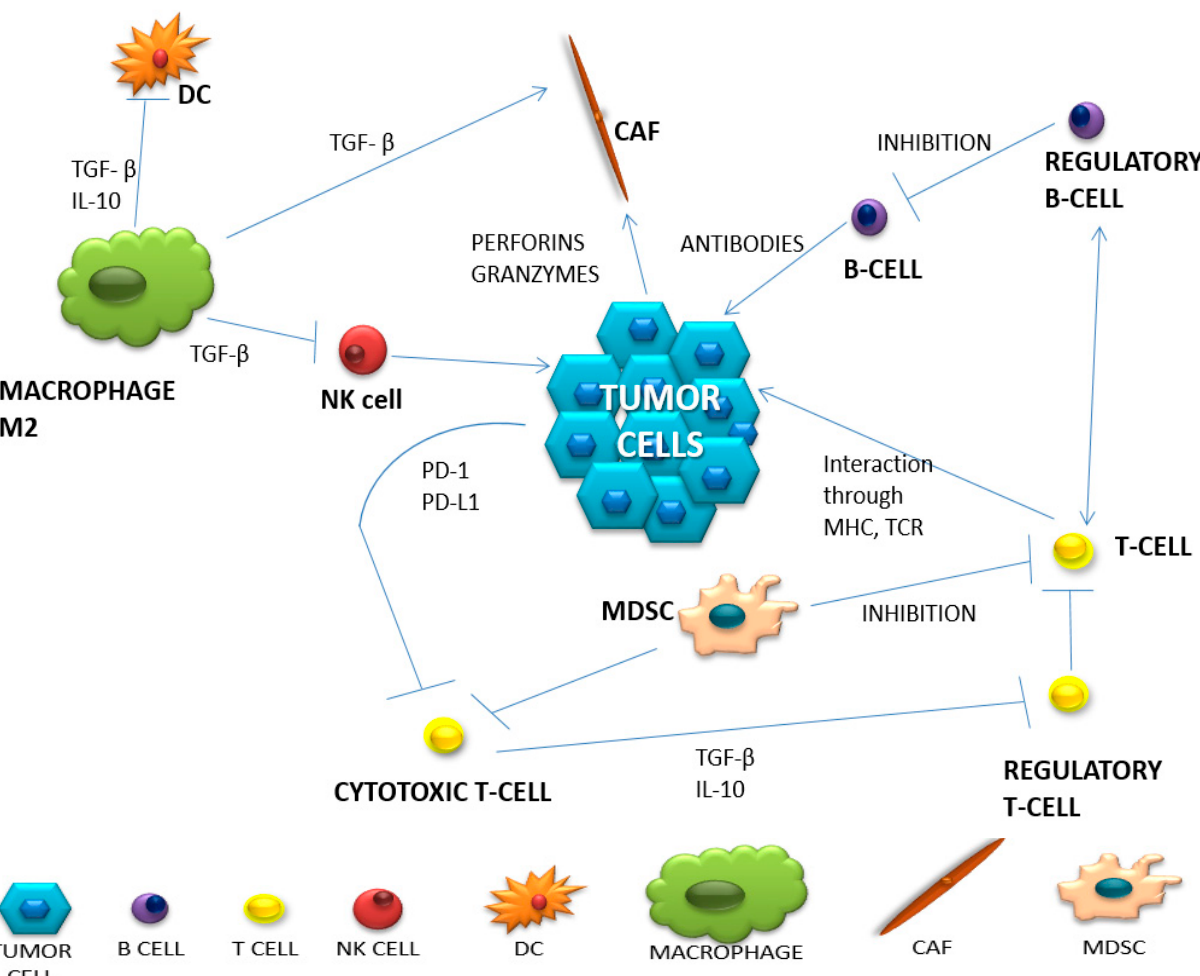
Figure 1. The network of intercellular interactions in the tumor microenvironment (based on Borros Arneth, 2019).